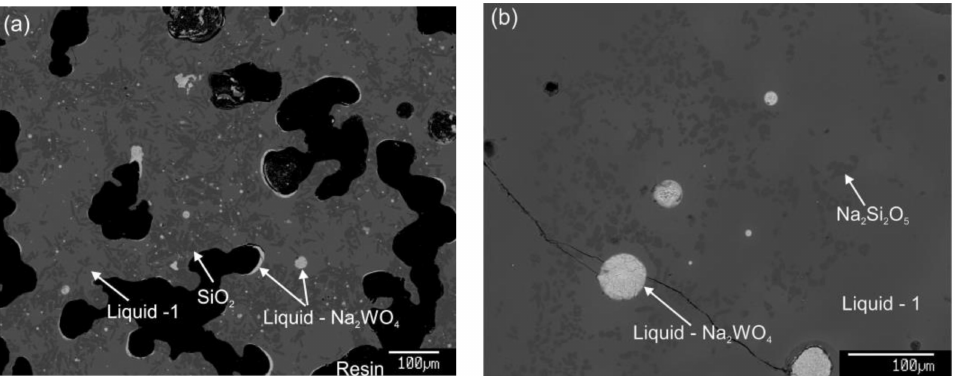
Figure 3. Typical backscattered scanning electron micrographs of the quenched samples in the Na 2 O-SiO 2 -WO 3 system showing equilibrium of liquid with ( a ) WE13—tridymite and liquid sodium tungstate, and ( b ) WE11—sodium disilicate and liquid sodium